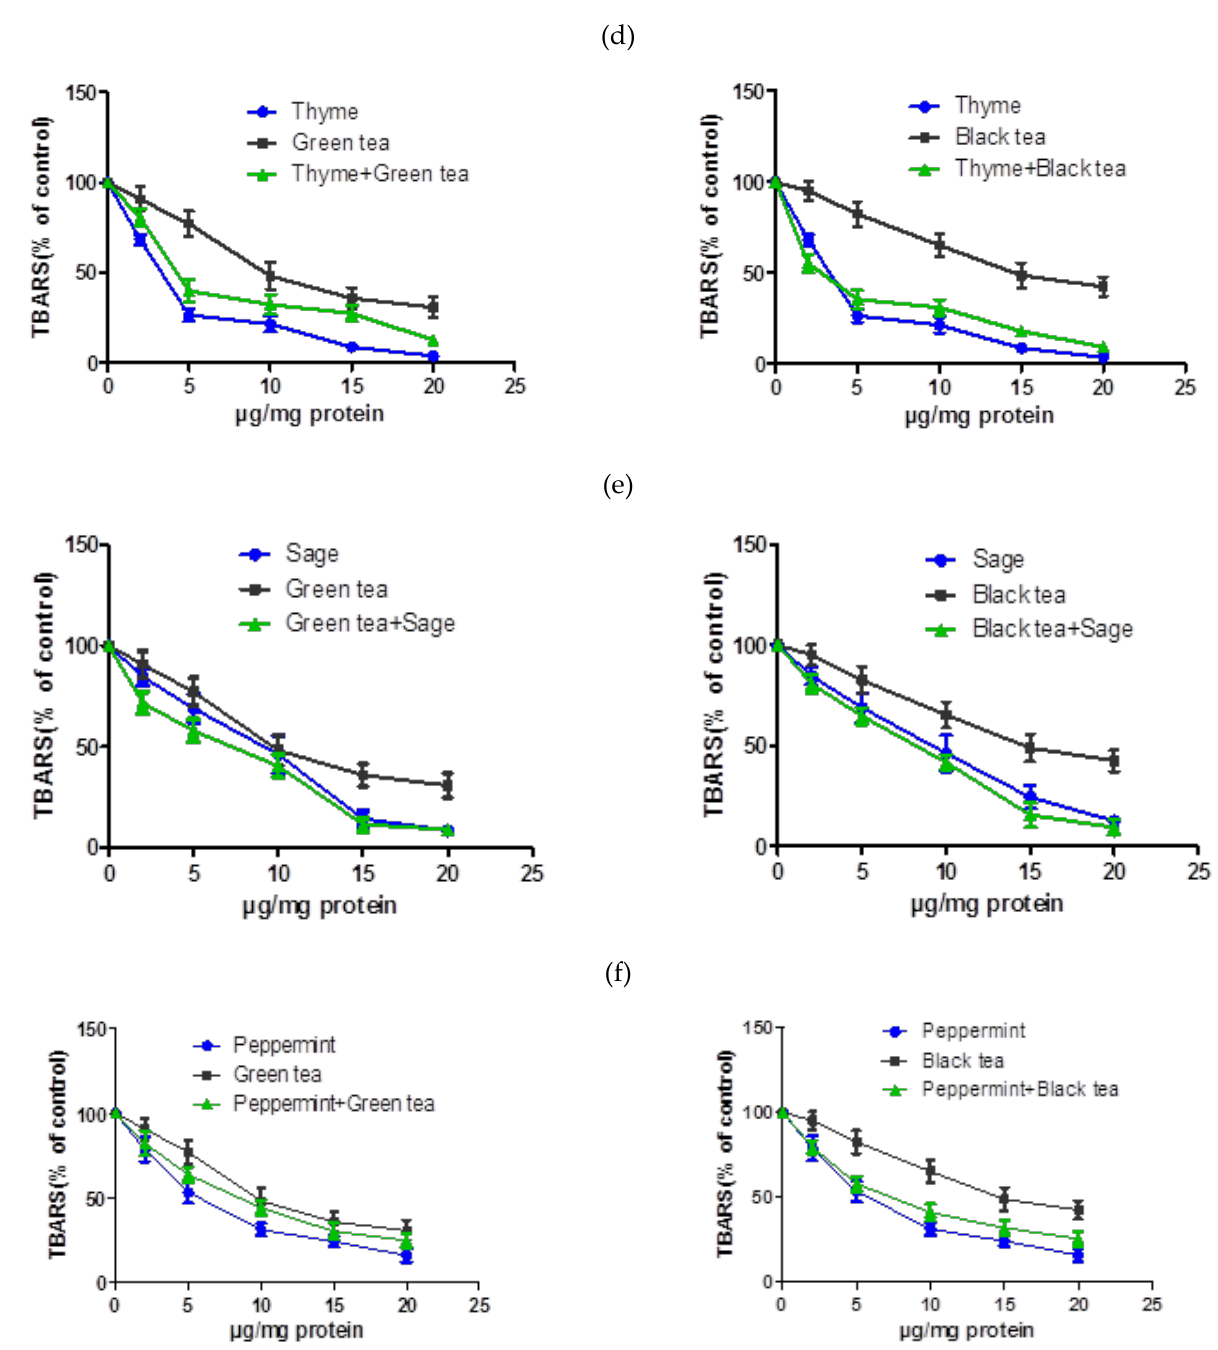
Figure 1. Comparison of single herbal and mixed extracts’ influence on Thiobarbituric Acid Reactive Substances (TBARS) level in liver microsomes in vitro experiments. Note: on the X-axis: extract concentration, µ g/mg, along the Y-axis: level of LPO processes, %. ( a ) oregano, ( b ) ziziphora, ( c ) dragonhead, ( d ) thyme, ( e ) sage, ( f ) peppermint.